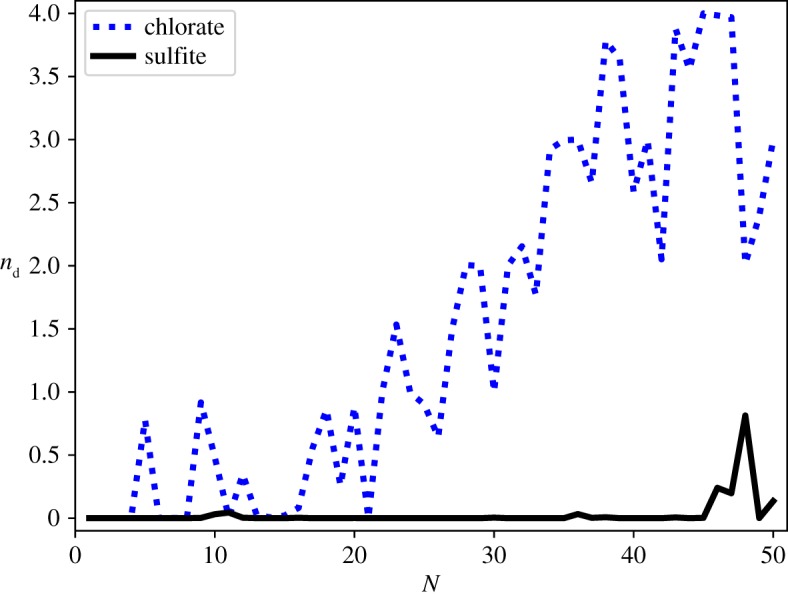
Boltzmann weighted mean number of dangling hydrogen bonds (nd) for SO32−(H2O)N and ClO3−(H2O)N clusters in the range 1≤N≤50. (Online version in colour.)